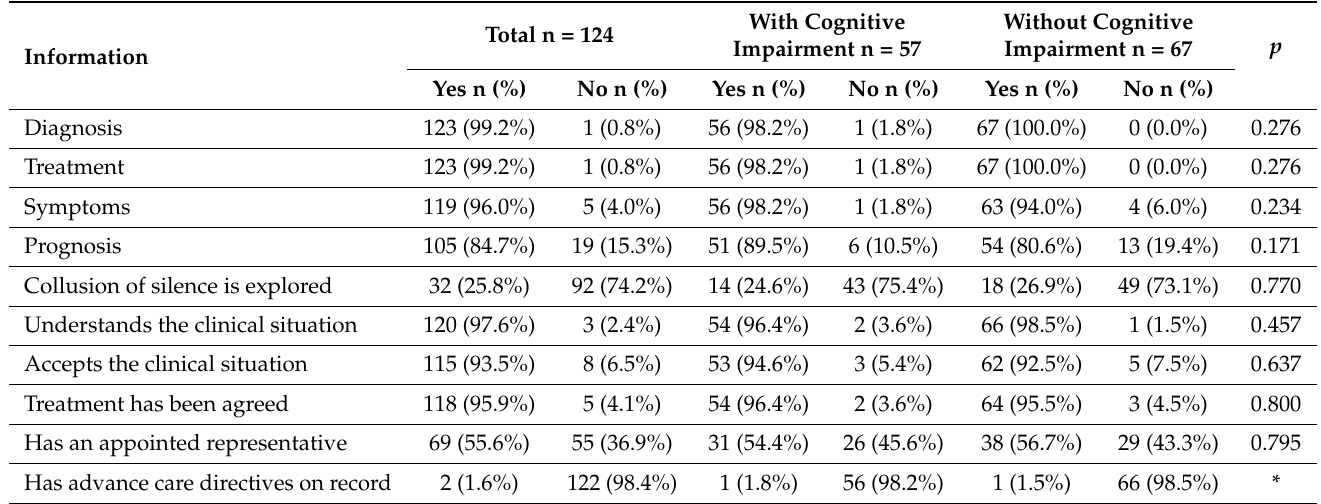
Table 2. Specific information held by the resident or family.